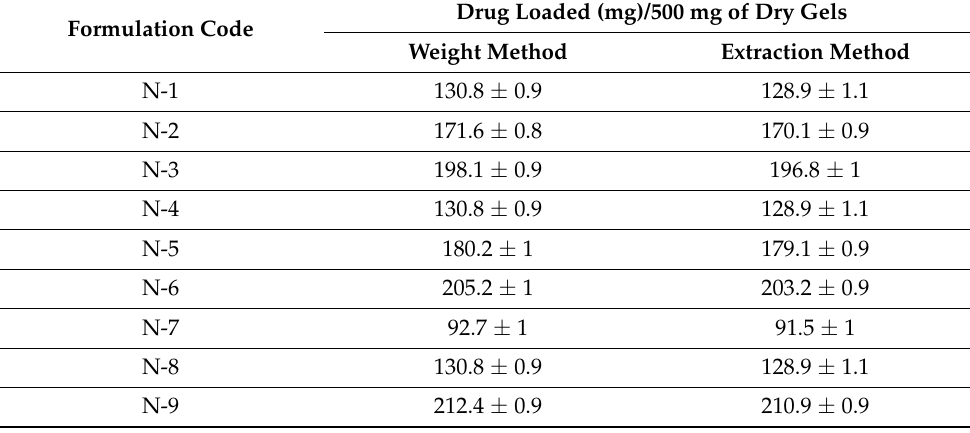
Figure 3. Effect of pH on ( A ) dynamic swelling and ( B ) percent of drug released from Cs/SpsCpAca hydrogel. Effect of ( C ) Cs, ( D ) Sps, and ( E ) Aca on percent of drug released from Cs/SpsCpAca hydrogel. Table 2. Drug loading of Cs/SpsCpAca hydrogels.